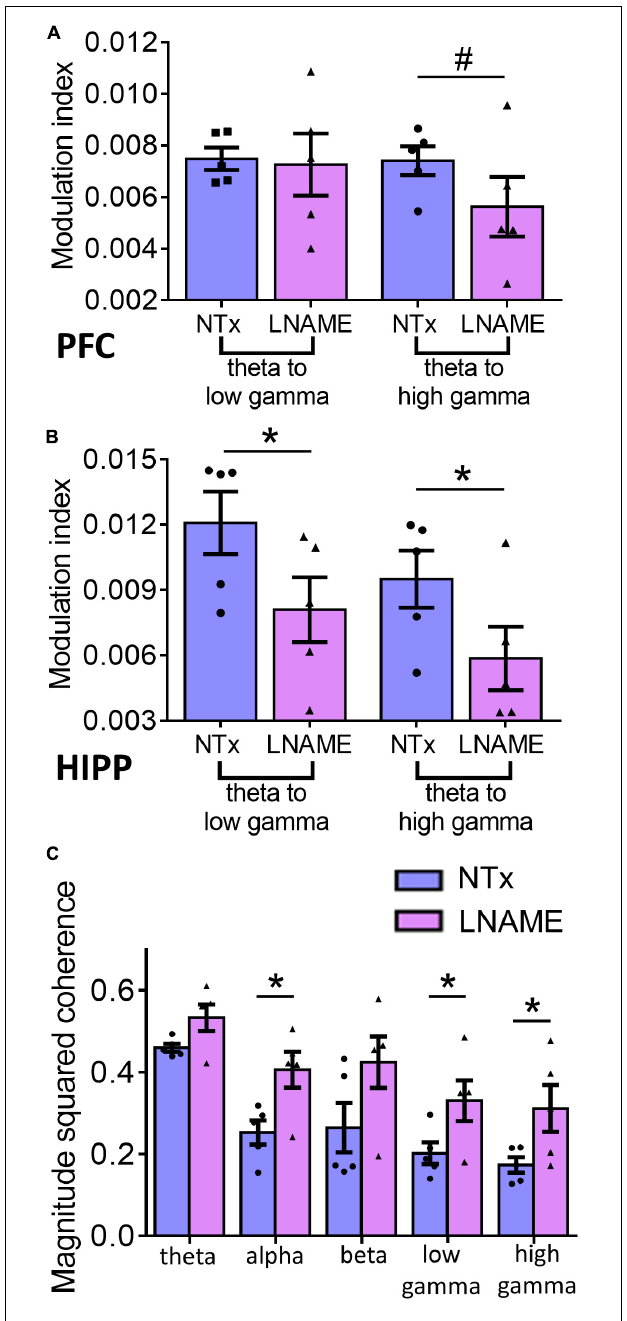
FIGURE 6 | Electrophysiological recordings show that injuries sustained from transient hypertension translate to impaired neuronal network function. (A) In PFC, theta to low gamma PAC was not significantly different between NTx and L-NAME rats ( p = 0.78), while theta to high gamma PAC was significantly smaller in L-NAME-treated rats ( p = 0.056). (B) In HIPP, both theta to low gamma PAC ( p = 0.016) and theta to high gamma PAC ( p = 0.021) were smaller in L-NAME treated rats. (C) MSC between PFC and HIPP: In alpha ( p = 0.018), low gamma ( p = 0.042), and high gamma bands (0.043), MSC was significantly increased in L-NAME-treated rats compared to NTx rats. In contrast, in theta ( p = 0.17) and beta ( p = 0.19) bands, MSC was not significantly different between L-NAME and NTx rats. * denotes p < 0.05; # denotes p < 0.06; n = 5 rats per